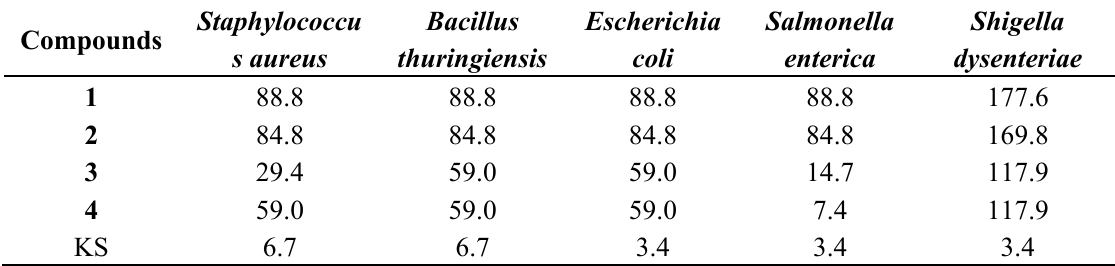
Table 2. MIC values of compounds 1 – 4 in μ M against five bacterial strains.